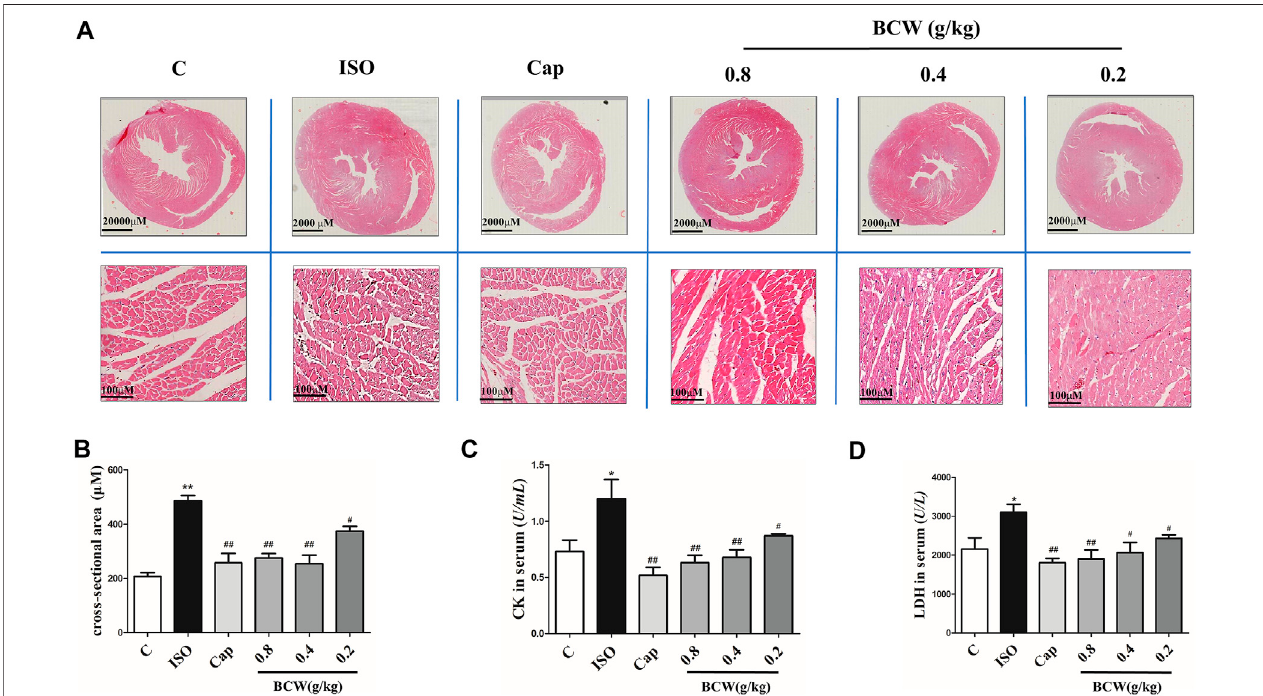
FIGURE 4 | BCW suppressedmyocardial hypertrophy induced byISO. (A) Representativeslidesofcardiac cross sections by hematoxylin and eosin; scale bar inA (cid:2) 2000 μ M,magni fi cation(10 × ),scalebarinB (cid:2) 100 μ M,magni fi cation(200 × ). (B) cross-sectionalarea(CSA)ofcardiomyocytes, (C and D) ThelevelsofCKandLDHinserum weremeasuredbycommercialkit,respectively.Resultsareshownasthemean ± SE.* p < 0.05vs.control,** p < 0.01vs.control; # p < 0.05vs.ISO, ## p < 0.01vs.ISO,n (cid:2) 10 in each